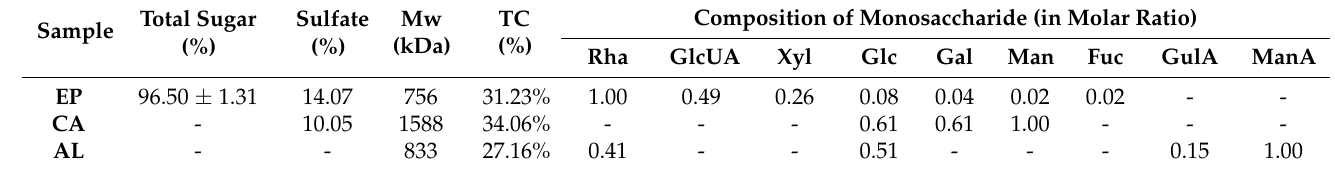
Table 1. Chemical analysis and